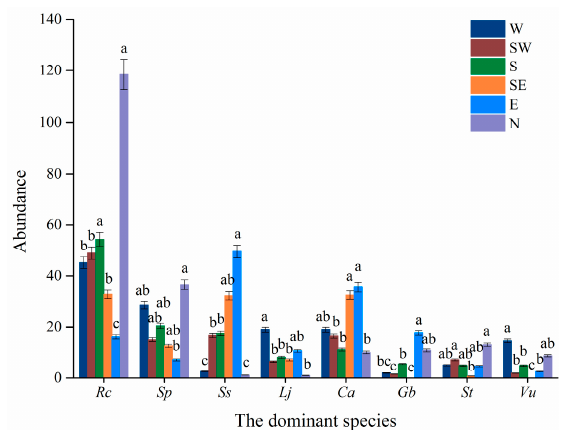
Figure 2. The abundance of the eight dominant species in relation to slope aspects. Note: Rc,